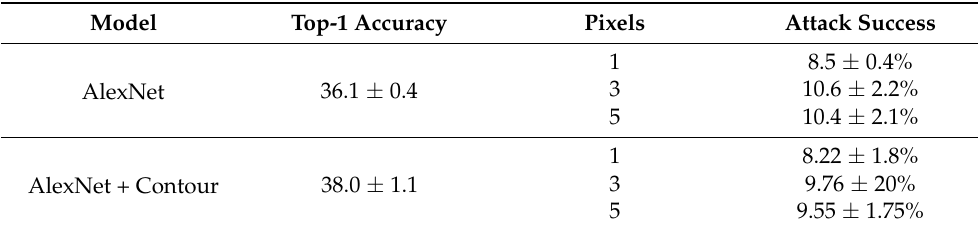
Table 1. Adversarial attack results by integrated contour model in [151].